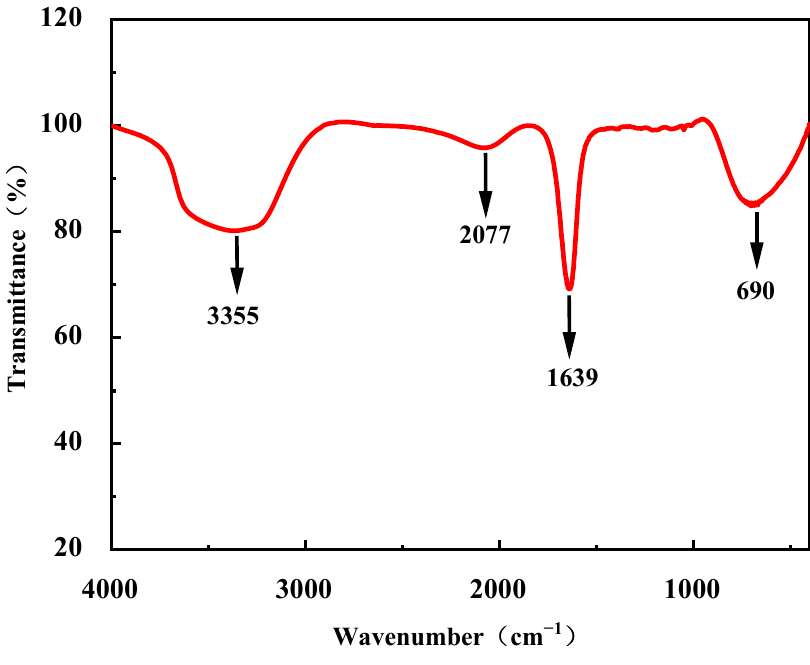
Figure 1. Infrared spectra of poly (MMA-BA-ST).